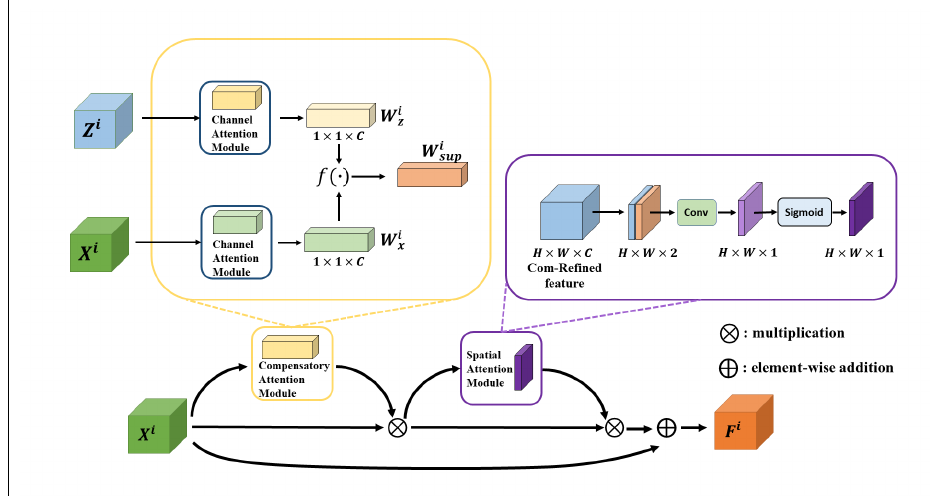
Figure 4. Compensated attention model for search